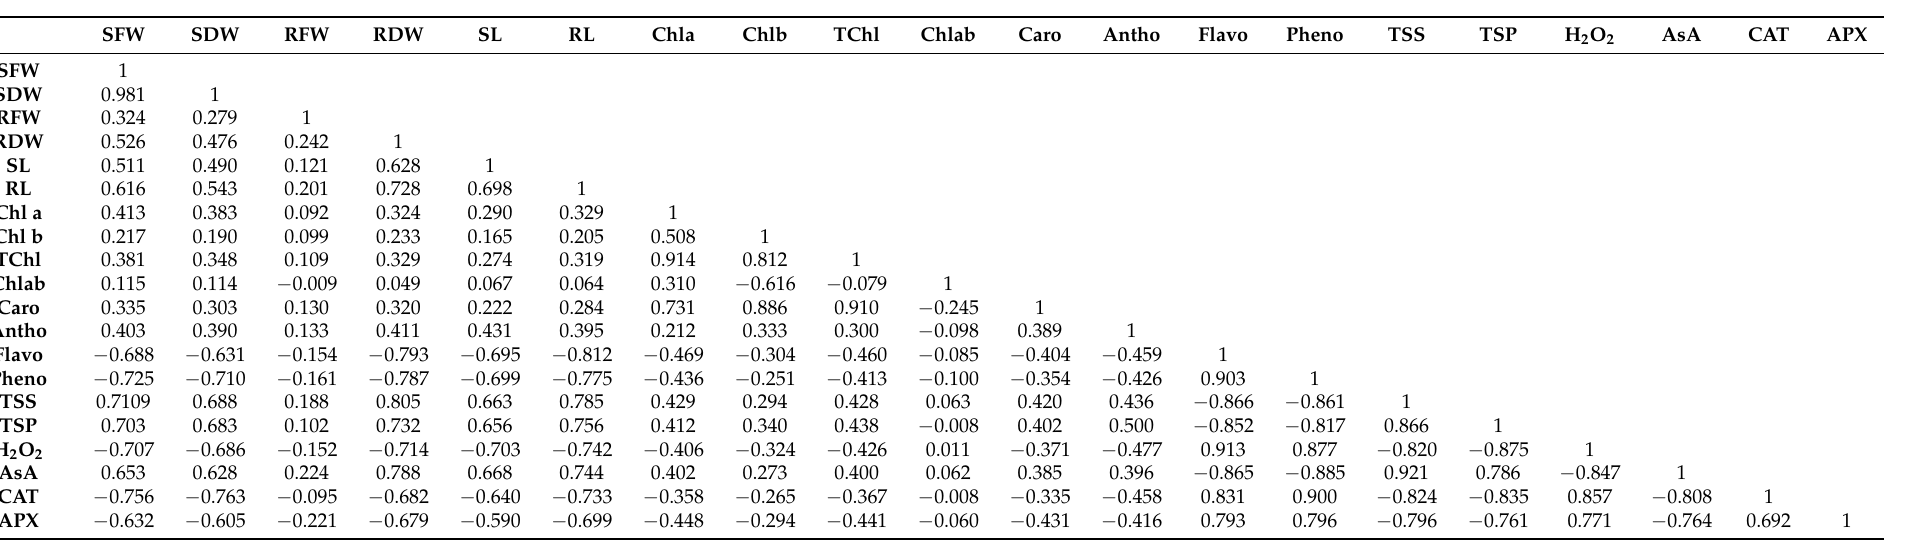
Table 4. Pearson’s coefficient correlation values of the estimated attributes of wheat ( Triticum aestivum L.) inoculated with Bacillus subtilis , Aspergillus niger and L-proline, showing significant differences under cadmium